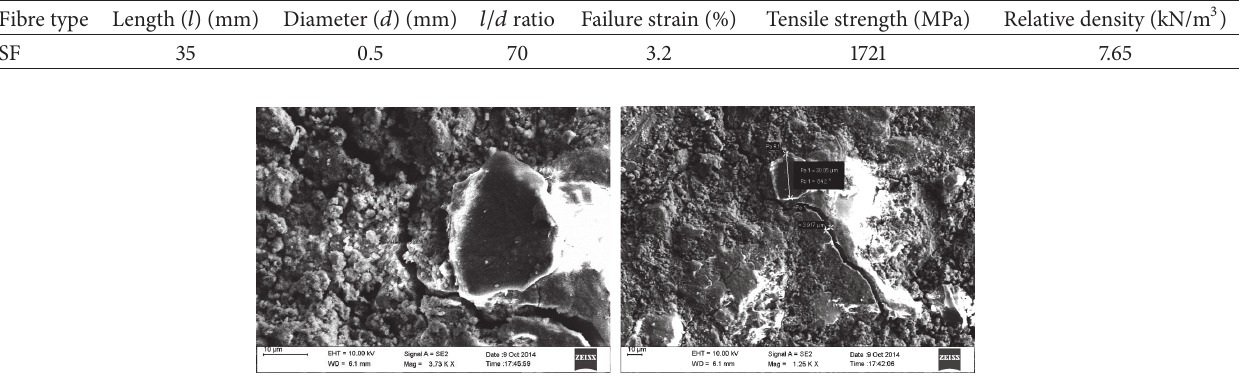
Table 3: Properties of glued steel fibres (SF).